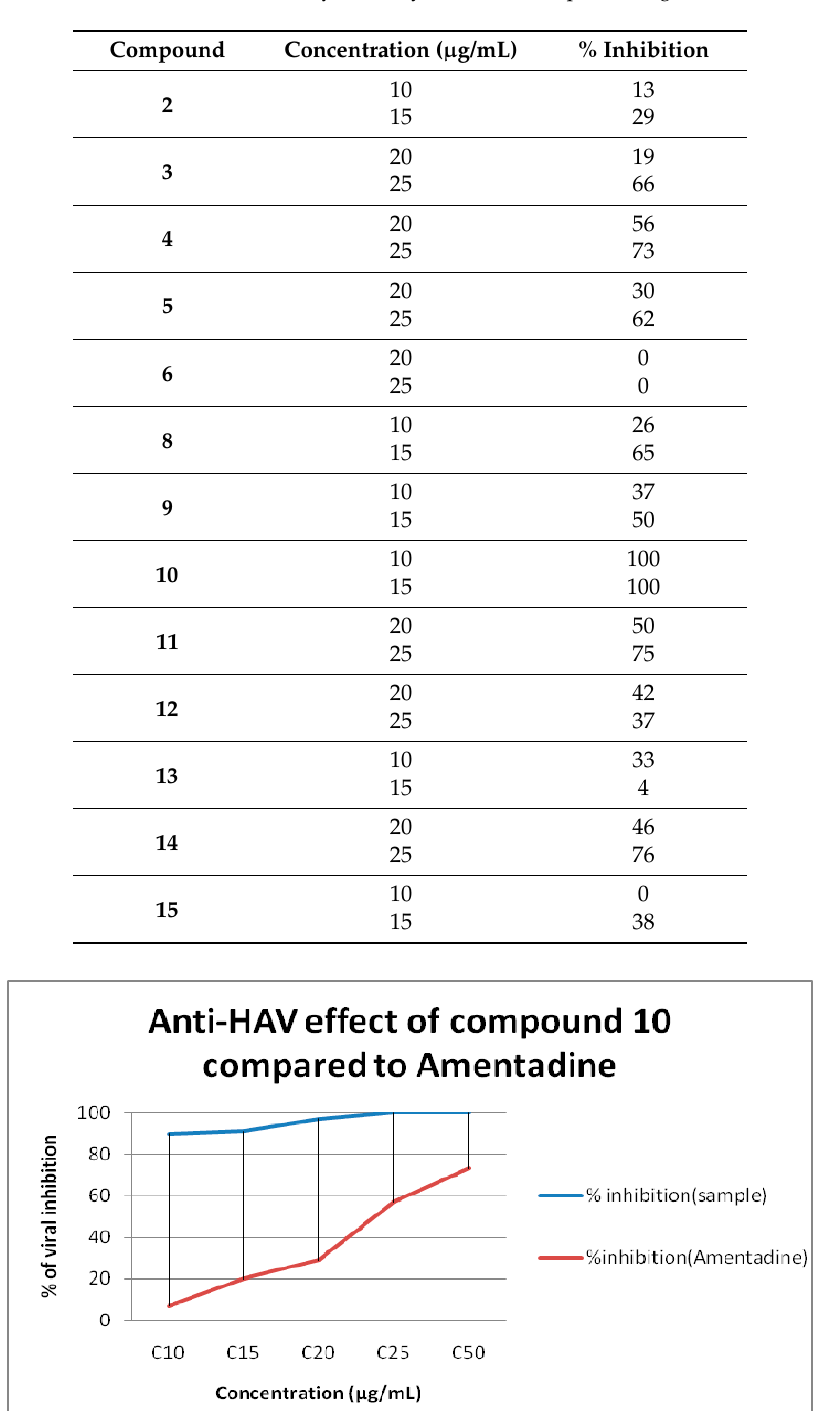
Table 2. The antiviral activity of the synthesized compounds against HAV. Compound